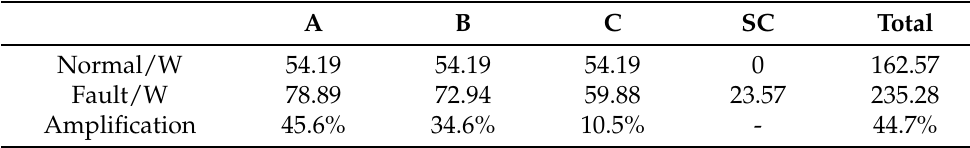
Table 4. Comparison of motor copper loss under normal and faulty conditions.